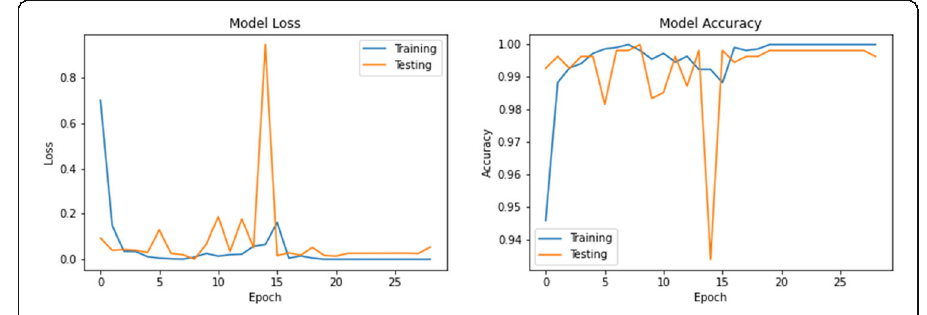
Fig. 11 Inception-ResNet-V2 accuracy loss graph